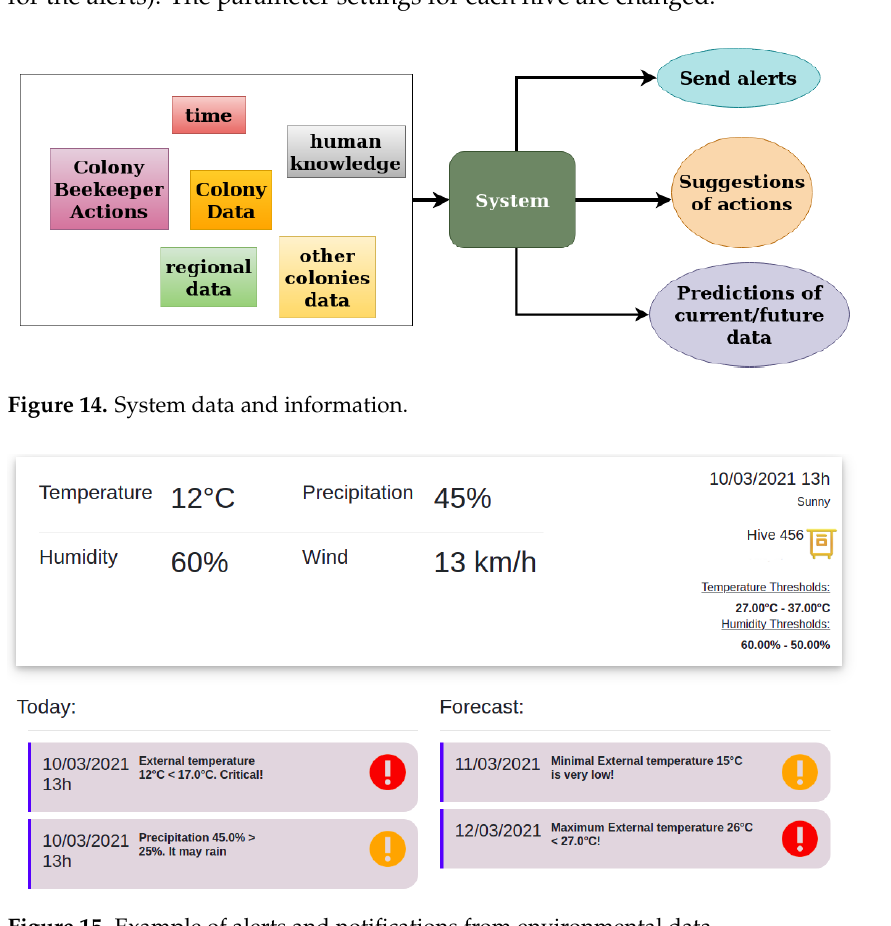
Figure 15. Example of alerts and notifications from environmental